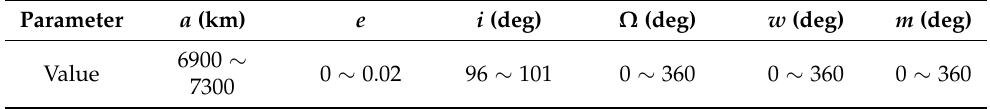
Table 1. The ranges of the six orbital